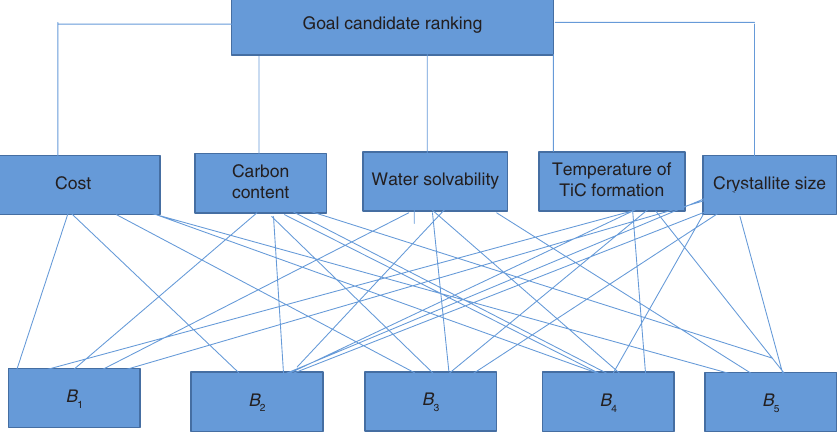
Figure 4: The Hierarchical Structure for the Carbon Source Selection